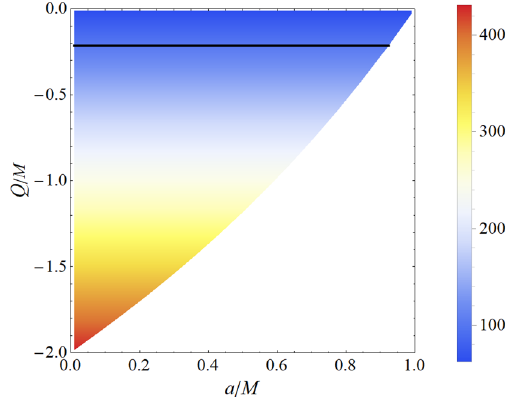
Fig. 10 Angular separation ( µ as ) between two images for Sgr A* black hole with source star at r s = 1400 M . The black solid line corre- sponds to 100 µ